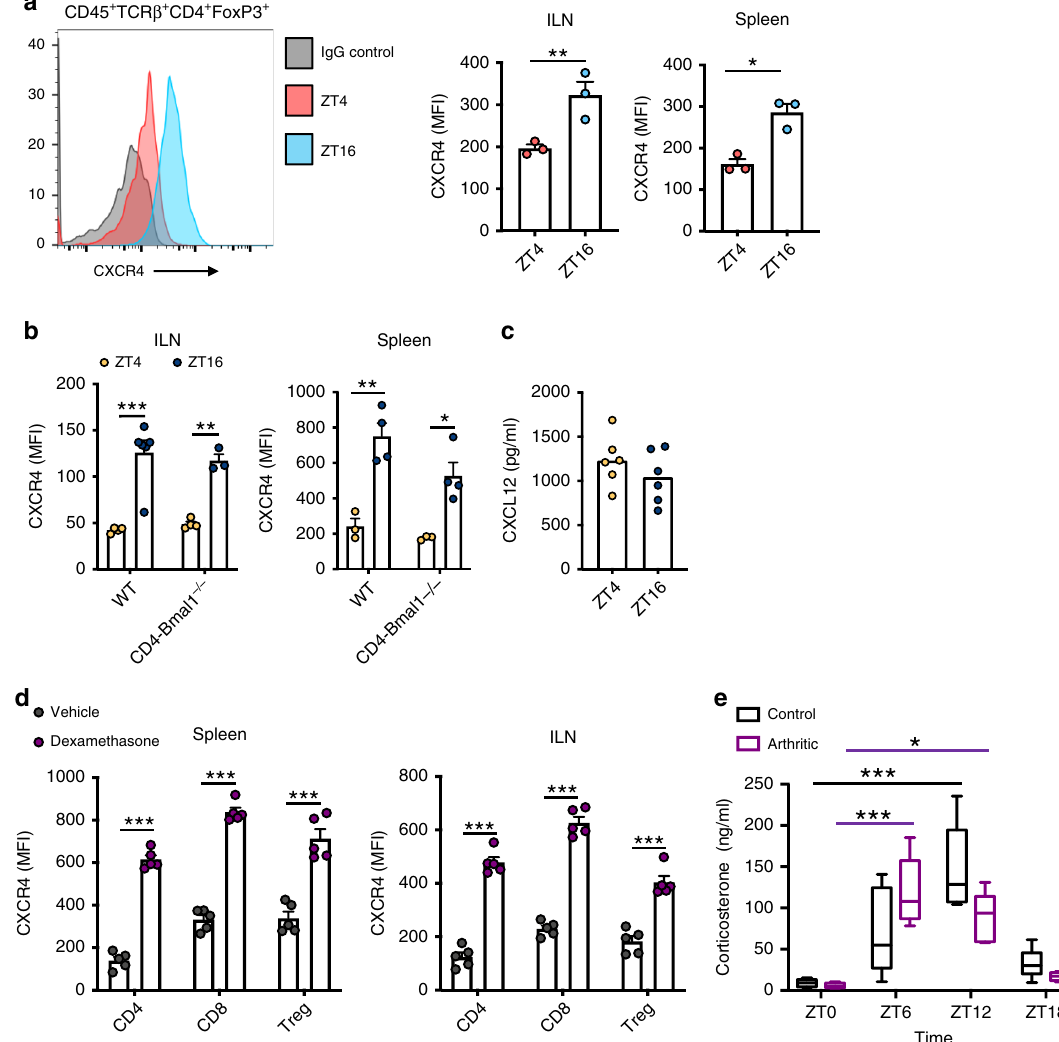
Fig. 4 Glucocorticoid action on Treg cells. a CXCR4 expression (geometric mean fl uorescent intensity) on Tregs from spleen and inguinal lymph nodes of wildtype mice harvested at ZT4 ( n = 3) or ZT16 ( n = 3) two-sided unpaired T- test. Data are presented as mean values ± SEM. b Diurnal rhythmicity in CXCR4 expression persists in the absence of Bmal1 ILN (ZT4: WT n = 4; CD4-Bmal1 − / − n = 4; ZT16: WT n = 6; CD4-Bmal1 − / − n = 3) and spleen (ZT4: WT n = 3; CD4-Bmal1 − / − n = 3; ZT16: WT n = 4; CD4-Bmal1 − / − n = 4), two-way ANOVA, post hoc Tukey. Data are presented as mean values ± SEM. c Plasma levels of CXCL12 in naïve mice at ZT4 and ZT16 ( n = 6/group). Graph shows individual data points and mean values. d Effects of 4 h in vivo application of dexamethasone (2 mg/kg) or vehicle (cyclodextrin) at ZT0 on CXCR4 expression on the surface of T cell subsets derived from spleen or inguinal lymph nodes ( n = 5/group). One-way ANOVA and post hoc Bonferonni. Data are presented as mean values± SEM. e Plasma corticosterone levels in naïve ( n = 6/time point) and arthritic (ZT0 n = 4; ZT6 n = 5; ZT12 n = 5; ZT18 n = 4) animals across a 24 h period (centre of box represents the medium and bounds extend from 25th to 75th percentile, whiskers are minima and maxima), two-way ANOVA (interaction between time-of-day and disease effect p = 0.0058; Time-of-day effect p < 0.0001; Disease effect NS) and post-hoc Tukey. In panels a – d statistical signi fi cance is shown as * p < 0.05, ** p < 0.01 and *** p < 0.005. In panel e * p < 0.05 and *** p < 0.005 indicates signi fi cant statistical differences between the indicated time-points in naïve animals (black lines) and arthritic animals (purple lines). Source data are provided as a Source Data fi